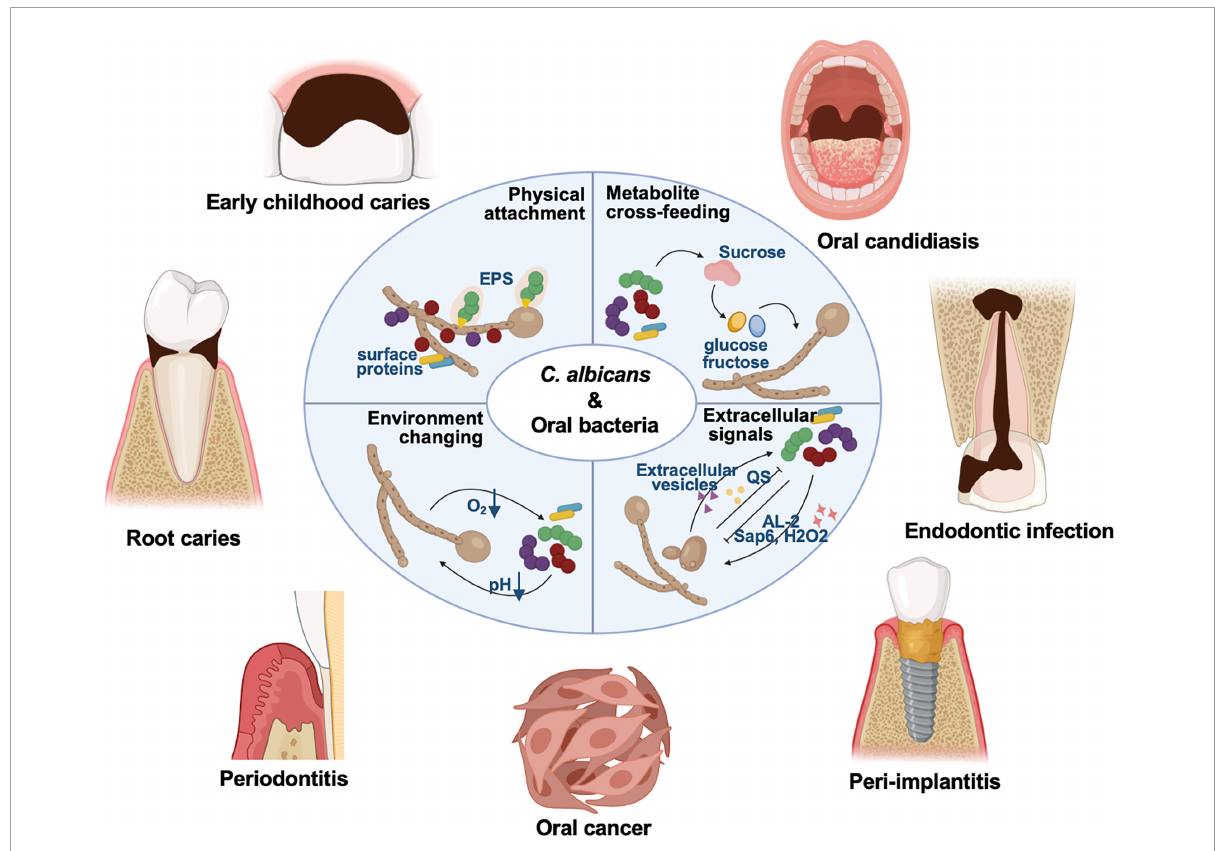
FIGURE1 C. albicans can interact with a variety of oral microbes, and these cross-kingdom interactions have been demonstrated involved in the pathogenesis of oral diseases for years, including dental caries, oral candidosis, endodontic disease, periodontitis, and other biofilm-related oral diseases. C. albicans can interact with oral bacteria via physical attachment through fungal cell walls (e.g., surface proteins and EPS), extracellular signals, metabolite cross-feeding, and environment